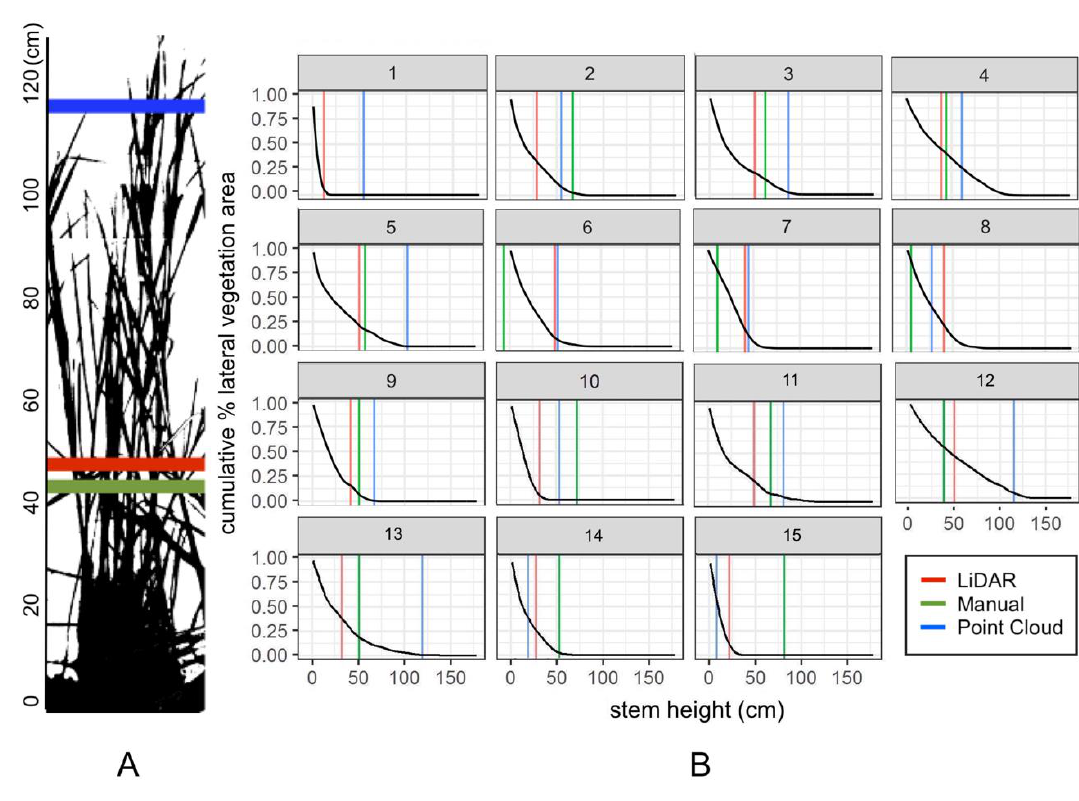
Figure 8. ( a ) An example plot is displayed to demonstrate the vertical profile (lateral obstruction) and associated vegetation height predictions across three different DTM generation methods post-transformation. ( b ) Inverse of the cumulative proportion of grass area encompassed at different stem heights across fifteen sampling quadrats after transformation with corresponding predicted vegetation heights from each of the three methods.